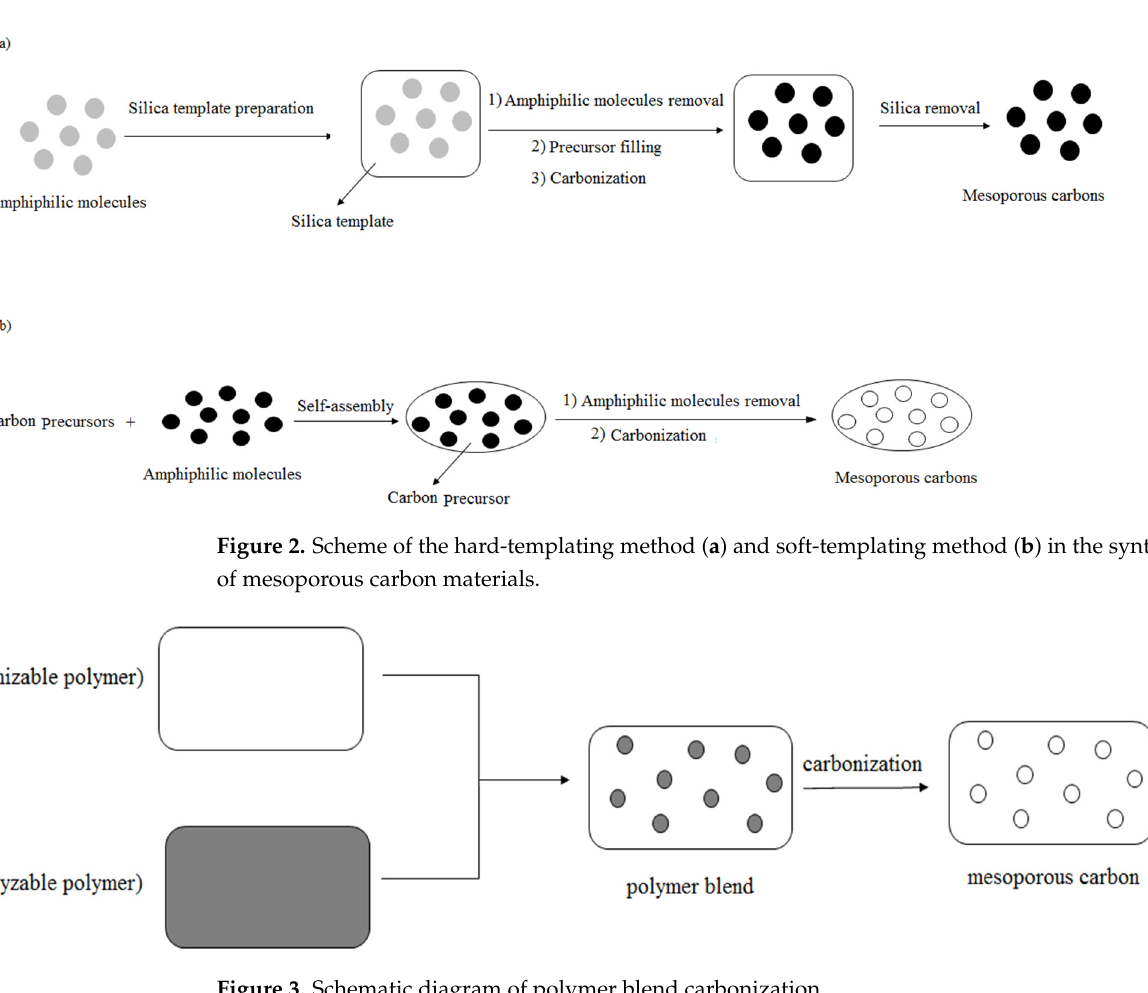
Figure 3. Schematic diagram of polymer blend carbonization.